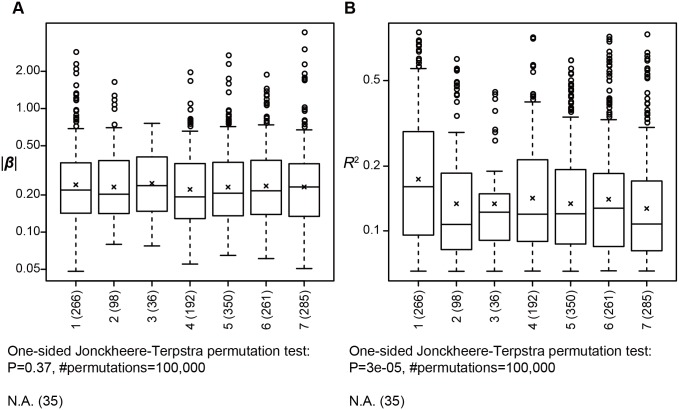
Trend in effects associated with regulatory classes of intergenic cis-eQTLs.The box-and-whisker plots show distributions of |β| values (A) or of R
2 values (B) of intergenic cis-eQTLs that affect mRNA transcripts for regulatory classes defined by the RegulomeDB. A cross indicates the mean effect of each class. The number of cis-eQTLs belonging to each class is shown in the parentheses following the class name. Jonckheere-Terpstra permutation test was used to test each trend, and the results are shown under the box-and-whisker plots. N.A.: not available.